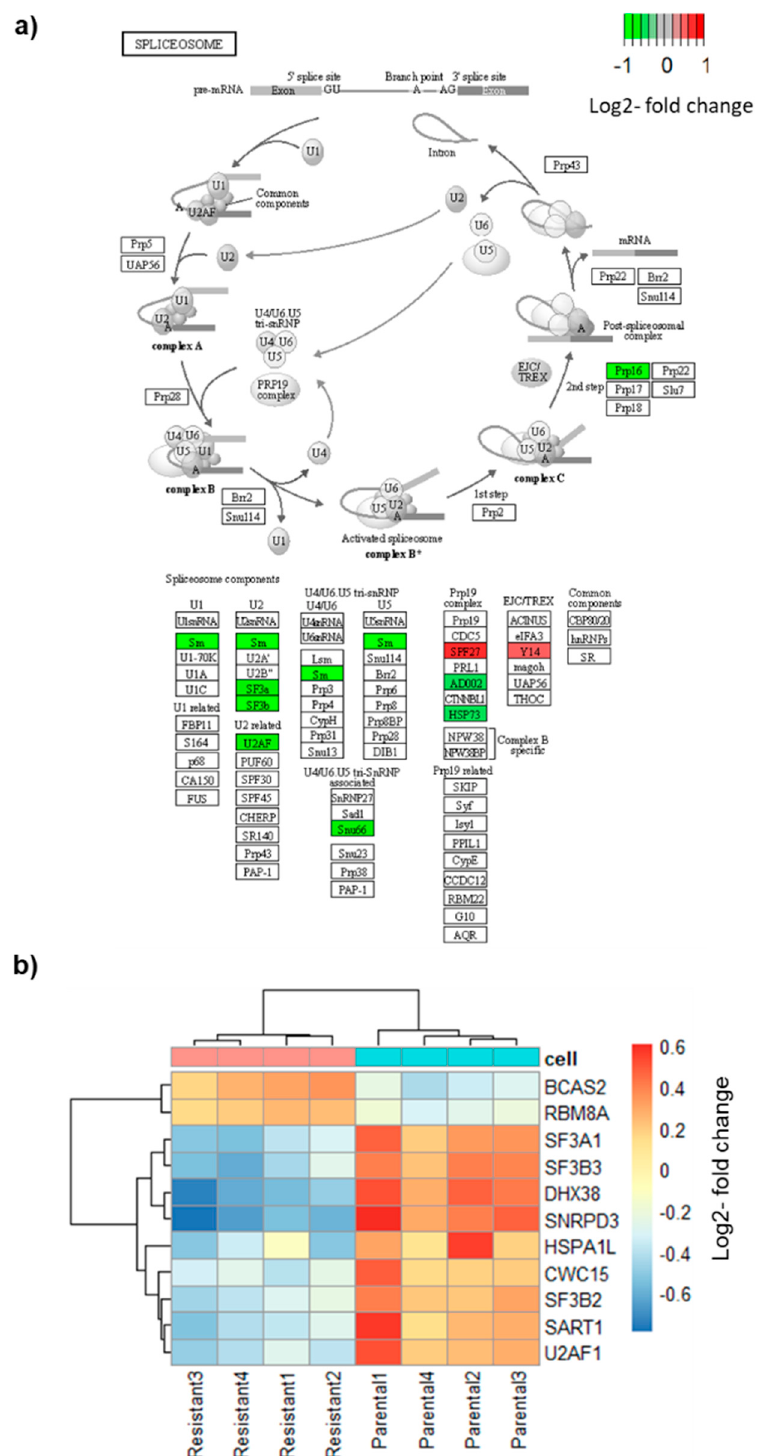
Figure 2. Differential expression of spliceosome genes. ( a ) Scheme of the spliceosome pathway from KEGG (KEGG_SPLICEOSOME, hsa03040). Red indicates downregulated genes, green upregulated gene. ( b ) Heatmap of differentially expressed spliceosome genes.